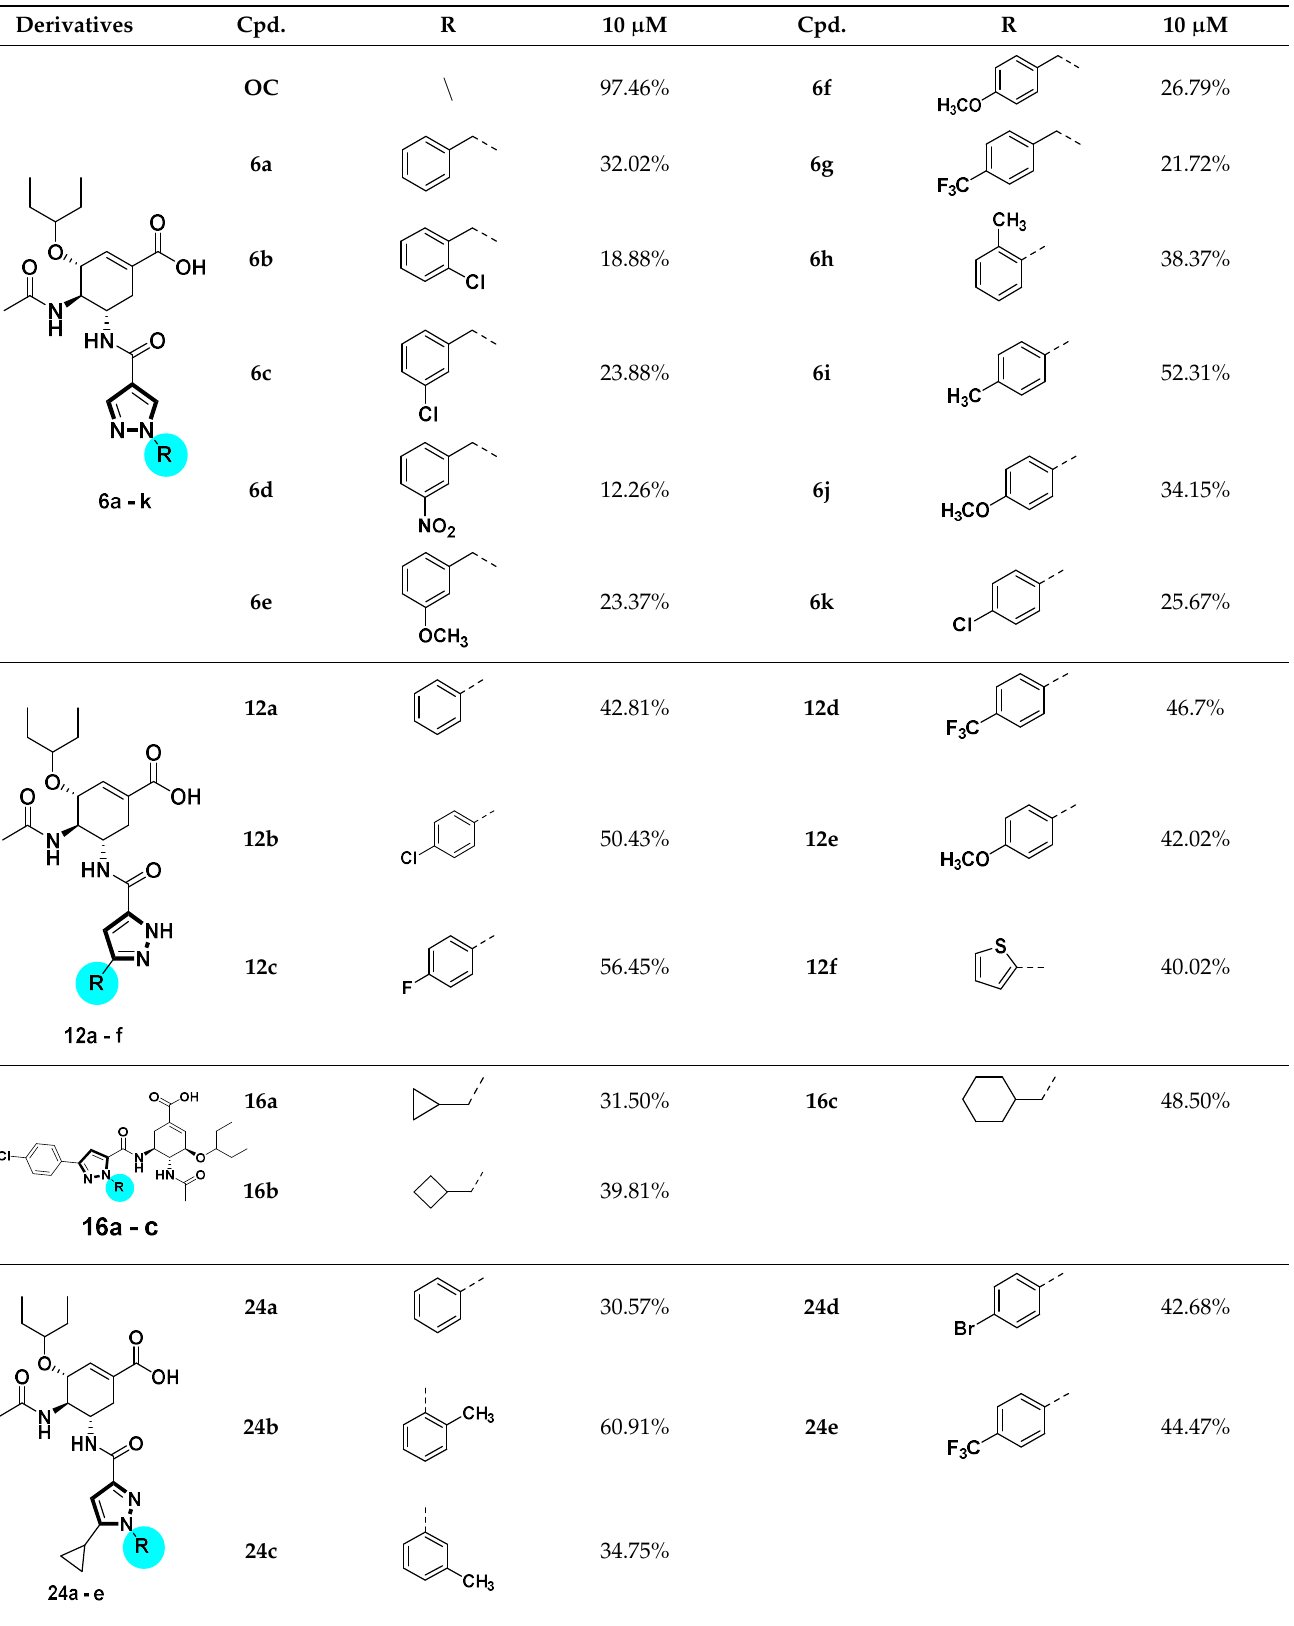
Table 1. Inhibitory rates of designed compounds against A/H3N2 influenza NA a . Derivatives Cpd.